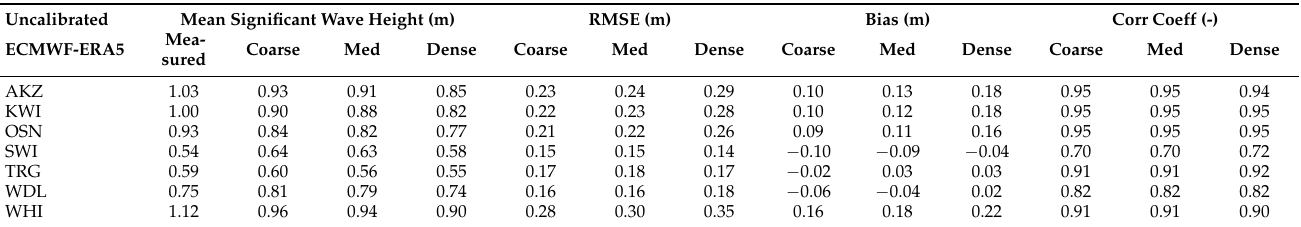
Table 13. Uncalibrated SWAN model forced by the ECMWF-ERA5 wind database showing the mean wave heights, RMSE, Bias and correlation coefficient relative to measured data at Belgian coastal measuring stations.